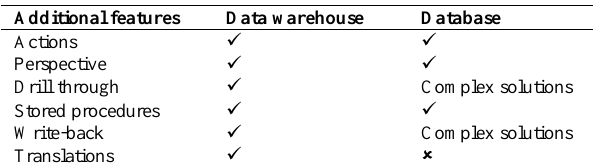
Table 1. Additional features.